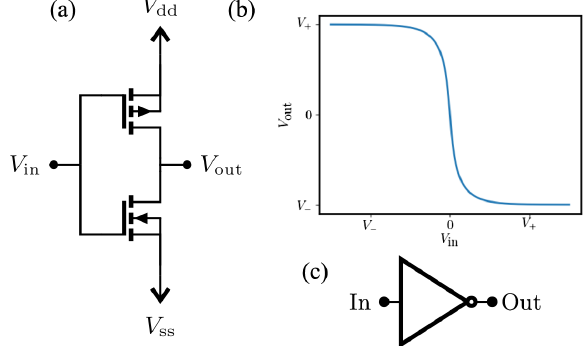
FIG. 7. (a) Common implementation of a NOT gate with CMOS technology. (b) Typical deterministic output voltage as a function of the input (for V the NOT gate.